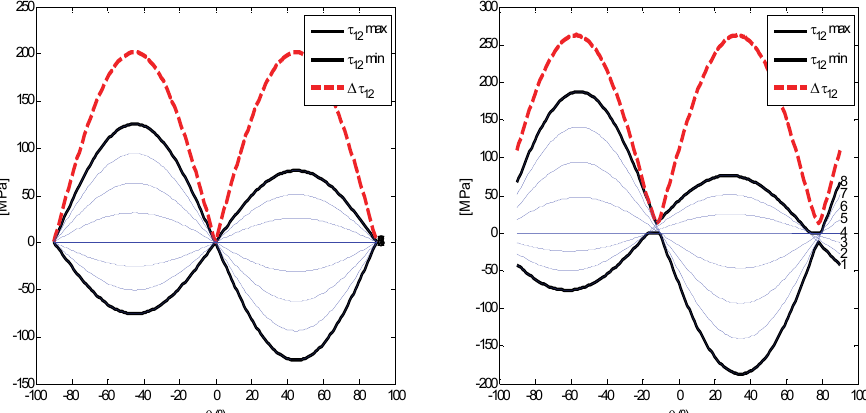
-100 -80 -60 -40 -20 Figure 8: Application of the min(  ) criterion for cases 14 (left) and 15 (right), leading to predicted angles of 90ºand 78º,